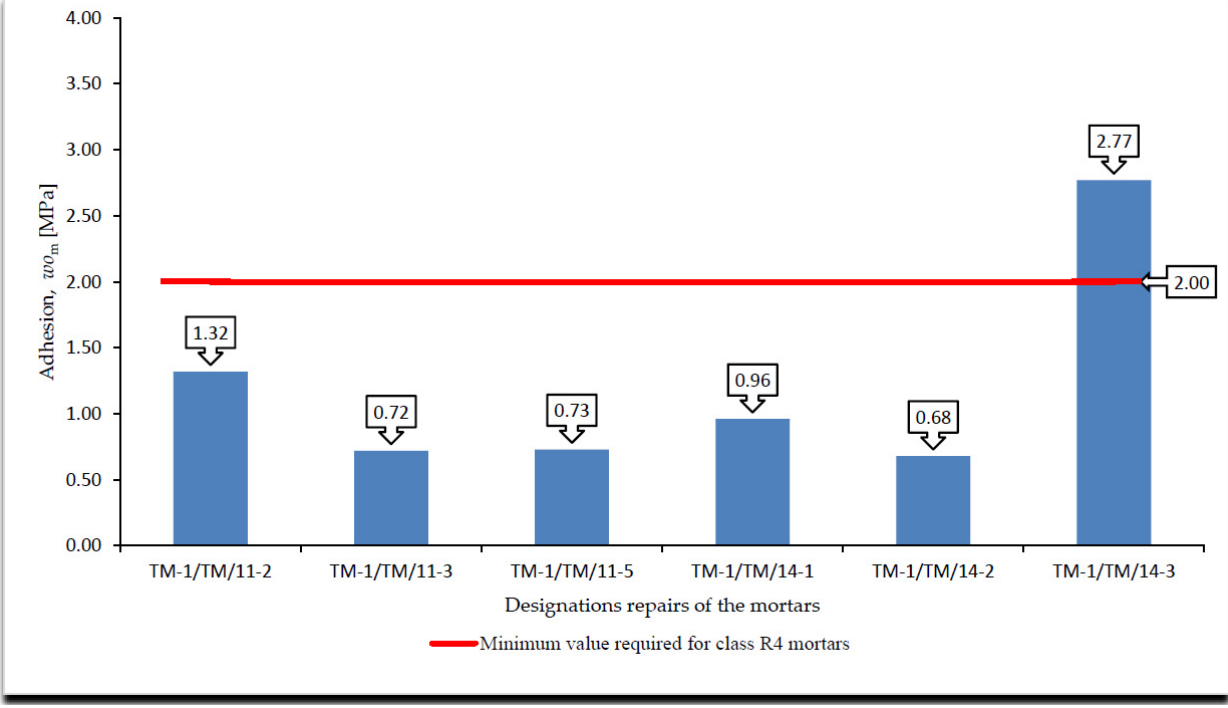
Figure 6. Summary of average values of adhesion by pull-off method for R4 class mortars to concrete substrate after frost resistance test, according to [18], wo m [MPa].